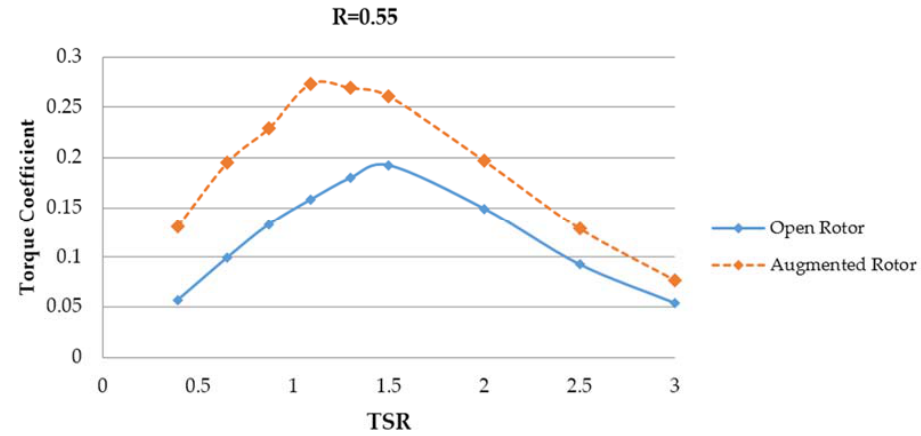
Figure 25. Torque coefficient versus TSR for open and augmented rotor.